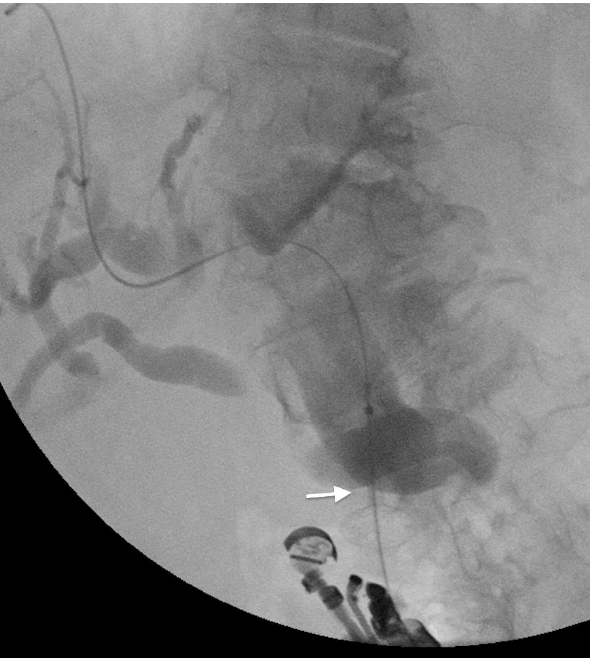
Figure 3. EUS-guided choledoco-duodenostomy with a lumen-apposing metal stent (arrow) to drain the bile duct in a patient with gallbladder cancer. Jin et al. performed a metanalysis including 302 patients with distant malignant bili- ary obstruction treated with EUS- or ERCP-guided biliary drainage [43]. They reported no differences in terms of technical success rate, clinical success rate, and total adverse events between the two procedures. EUS-BD presented a lower incidence of post-proce- dural pancreatitis, stent dysfunction, and tumor ingrowth. In another metanalysis, Han et al. included 756 patients and reported no significant differences between EUS-BD and ERCP in terms of success rate and safety [44]. 3. Gastric Outlet Obstruction (GOO) Patients with advanced GBC can present mechanical gastric outlet obstruction (GOO) due to duodenal compression or infiltration [45]. The clinical presentation of GOO includes early satiety, postprandial epigastric tenderness, nausea, vomiting, anorexia, weight loss, epigastric pain, and dyselectroliteemia [46]. Most patients with GOO have a